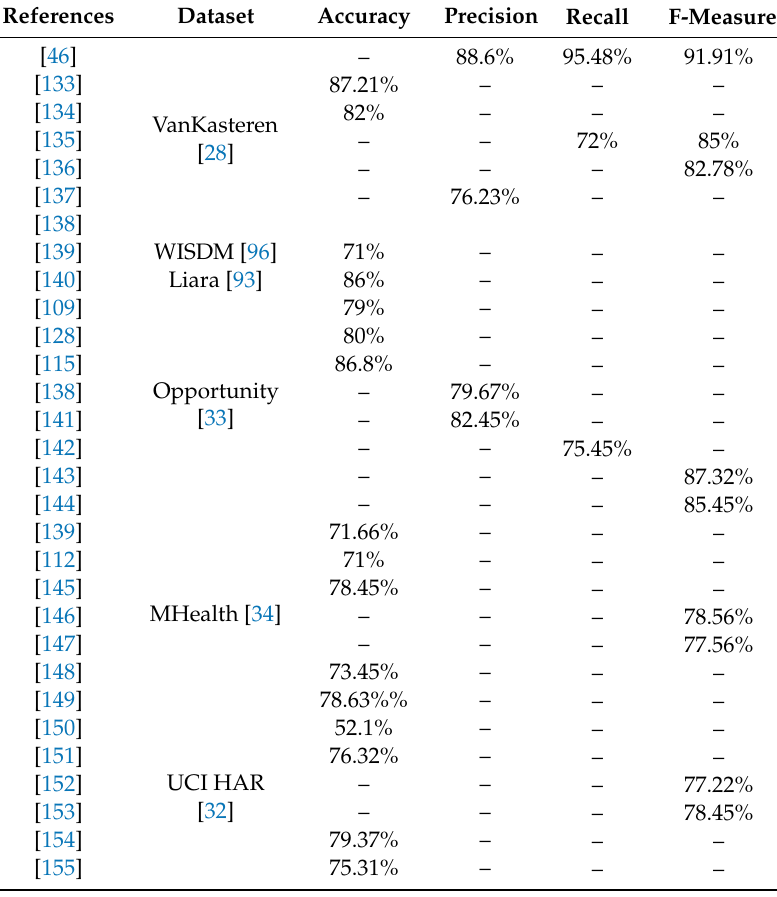
Table 9. Details of the K-means experimentation.